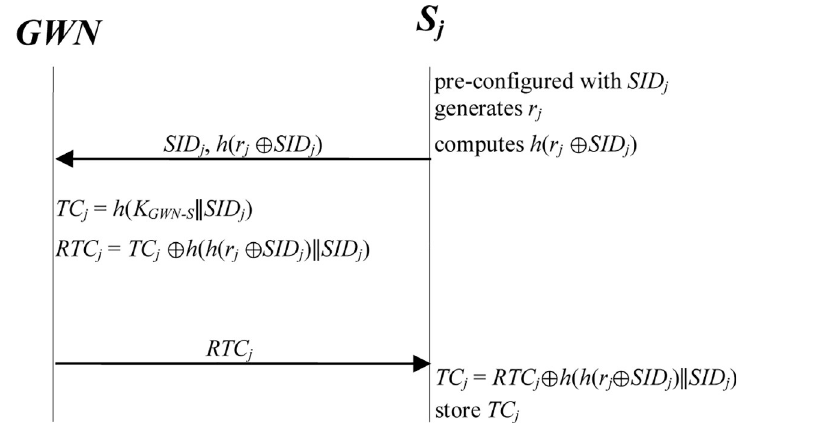
Fig 3. Registration phase for sensor nodes in the proposed